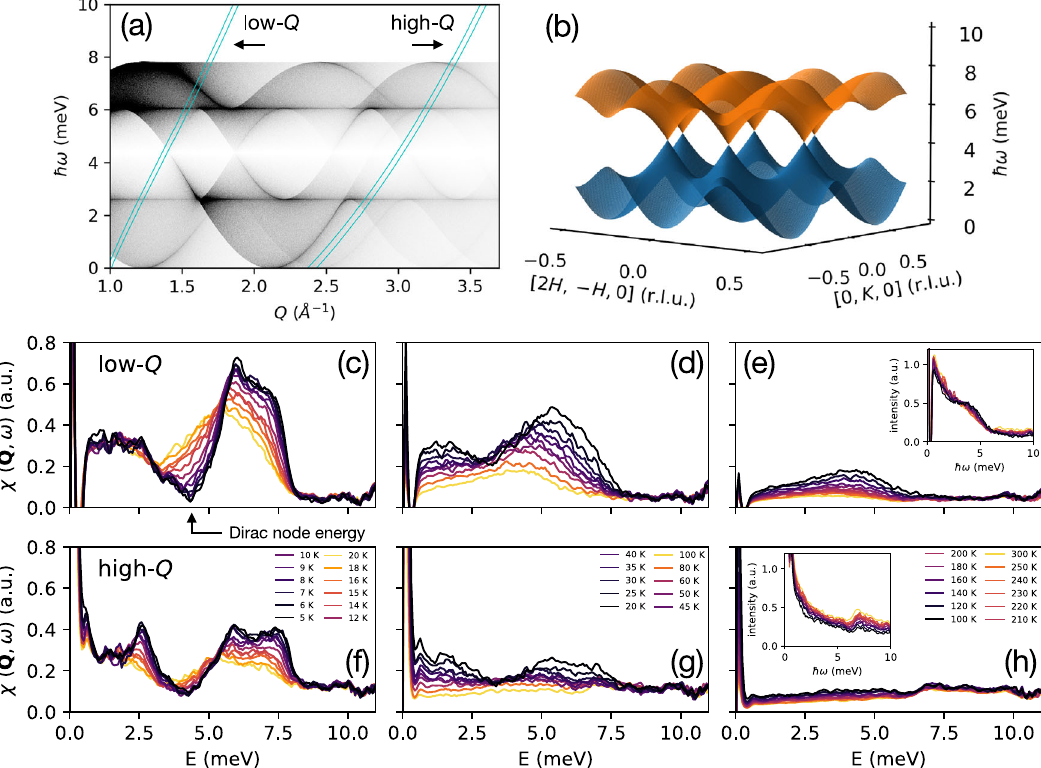
Fig. 3 Dispersion and temperature-dependence of magnetic excitations. a Powder-averaged S ? Q ; ω ð Þ simulated via SpinW, with low- and plane from fi tted magnetic exchange coef fi cients. c – h Bose- high- Q trajectories depicted in light blue. b Spin-wave dispersion in the HK 0 ð Þ R factor-corrected inelastic neutron scattering intensity in the temperature ranges of ( c , f ) 5 – 20 K, ( d , g ) 20 – 100 K, and ( c , h ) 100 – 300 K, along the ( c – e ) low- Q and ( f – h ) high- Q trajectories. Insets of ( e ) and ( h ) show the uncorrected intensities of the data in those panels. All intensities smoothed, and error bars not included for